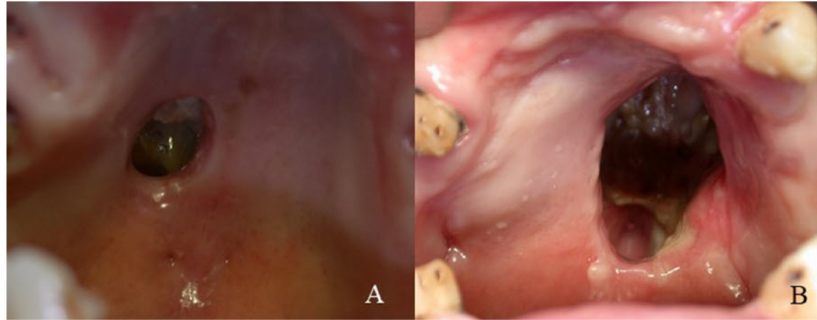
Figure 1. ( A ) Clinical aspect of case No. 2; ( B ) clinical aspect of case No.